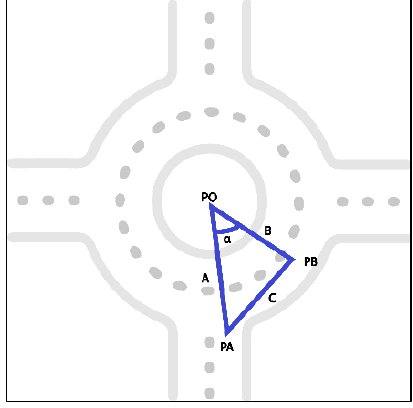
Figure 10. Segmentation in the 45-degree angle section within the roundabout.